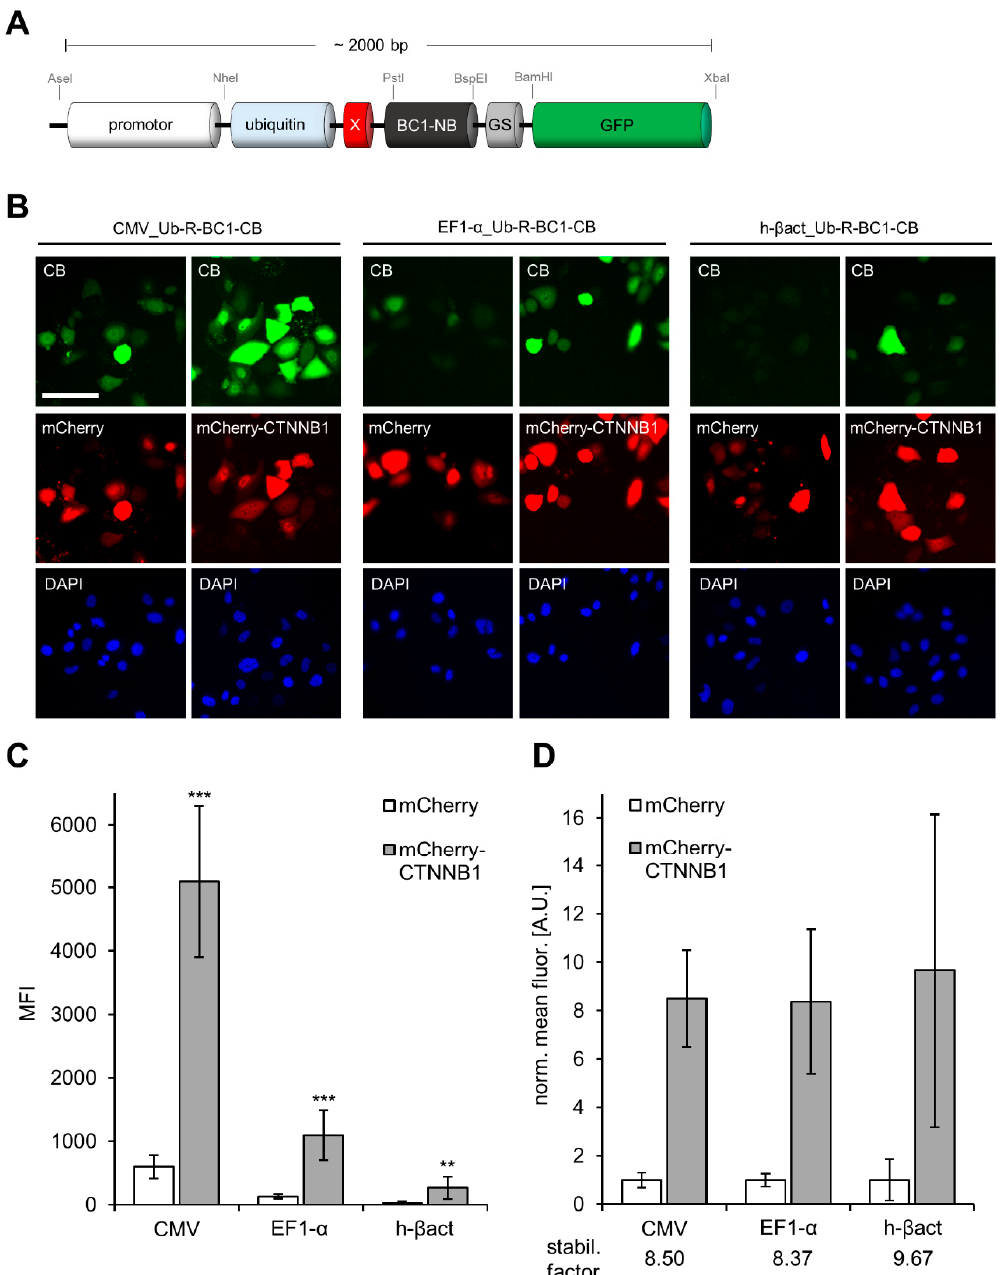
Figure 3. Quantitative image analysis of promoter-driven Ub-R-BC1-eGFP expression. ( A ) Schematic illustration of the CB expression construct for promoter testing. Promoter sequences can easily be exchanged using unique indicated restriction sites (AseI, NheI). ( B ) Representative images of HeLa cells transiently expressing Ub-R-BC1-CB driven by different promoters (CMV, EF1- α and h- β act) in combination with either mCherry (control) or mCherry-CTNNB1 (antigen). Nuclei were stained with DAPI, scale bar: 50 µ m. ( C ) Bar chart represents mean CB fluorescence intensity (MFI) detected by quantitative fluorescence imaging in either control (mCherry) or antigen (mCherry-CTNNB1) expressing cells ( n = 3, >200 cells each). ( D ) For every promoter construct, MFI of the CB in antigen expressing cells was normalized to the respective CB-signal determined in cells co-expressing mCherry as control, leading to the indicated stabilization factors. Error bars: S.D. Statistical analysis was performed using student’s t -test, *** p < 0.001, ** p < 0.01.